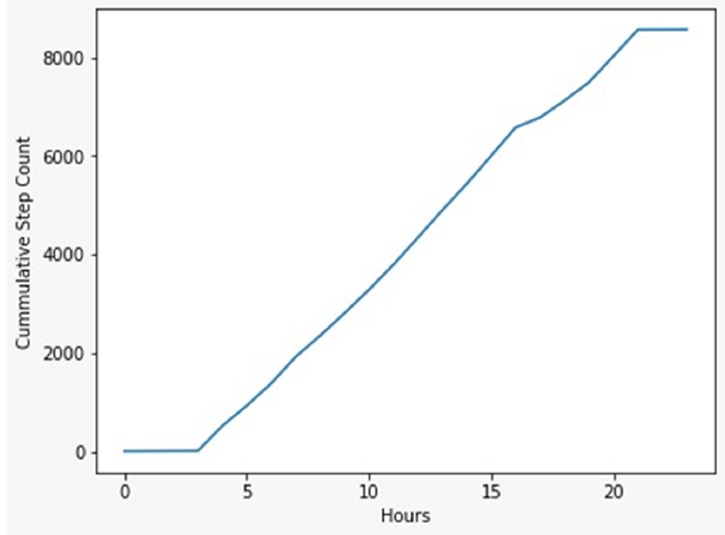
Figure 3. Spline-fitted data representation for second-level clustering. This spline-fitted data were used as input to process the second-level clustering. Spline fitting reduced the noise in the step count trajectories and smoothened the data curve. The 24 data points representing each hour of the day were obtained from the data and joined to form a step count trajectory, featuring both sedentary thresholds and spikes. The passive threshold determined whether the user was inactive for that hour. In order to analyze the user’s activity pattern, we used the spline-fitted data to perform the second level of clustering. Then, the statistical measure of the cumulative step count data was extracted from the spline graph. 3.3.5. Second-Level Clustering The second level of clustering took spline-fitted data as the input. This clustering step was performed to divide the users of each contextual user group on the basis of their daily activity pattern. Here, we used the hierarchical agglomerative clustering methodology to cluster each contextual user group on the basis of the time for which the user performed the physical activity. The daily activity pattern of individuals were defined as follows: 1. Morning intense, 2.